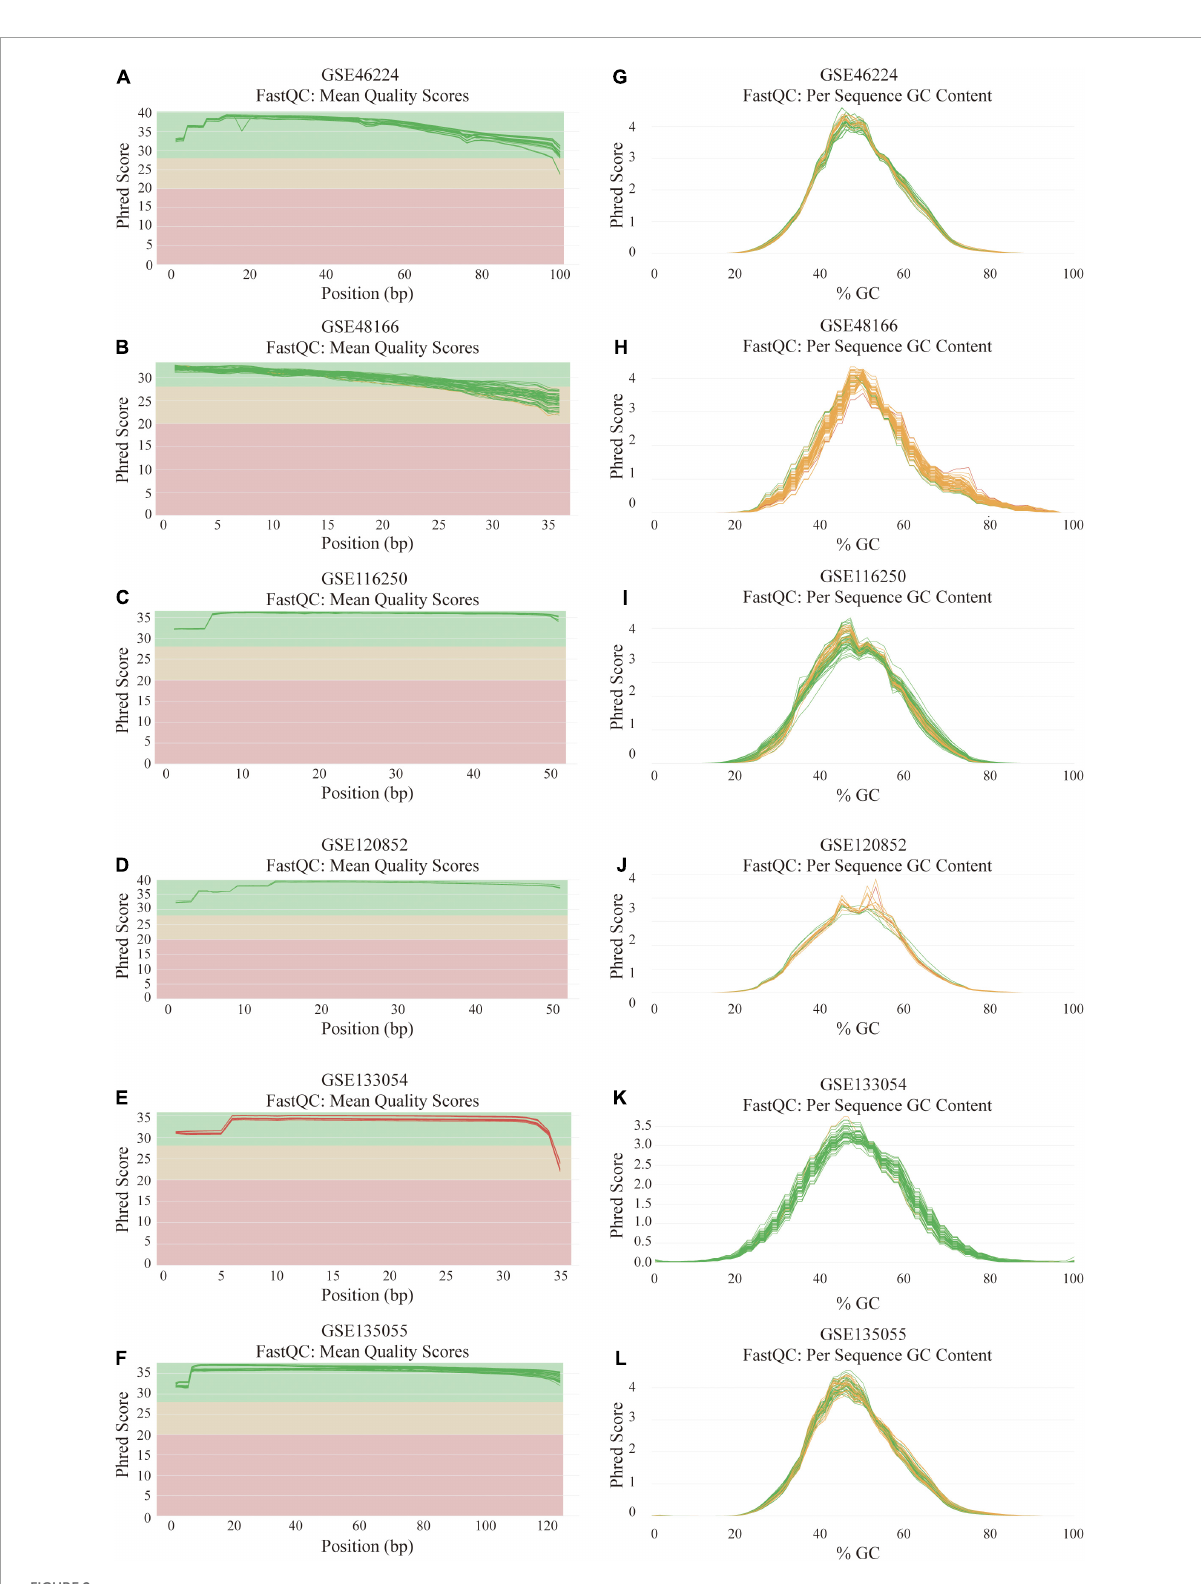
FIGURE2 Quality assessment and GC count evaluation of the data from six RNA sequencing datasets. (A–F) Per base sequence quality across all samples of GSE46224 (A) , GSE48166 (B) , GSE116250 (C) , GSE120852 (D) , GSE133054 (E) , and GSE135055 (F) . (G–L) Per sequence GC content across all samples of GSE46224 (G) , GSE48166 (H) , GSE116250 (I) , GSE120852 (J) , GSE133054 (K) , and GSE135055 (L)